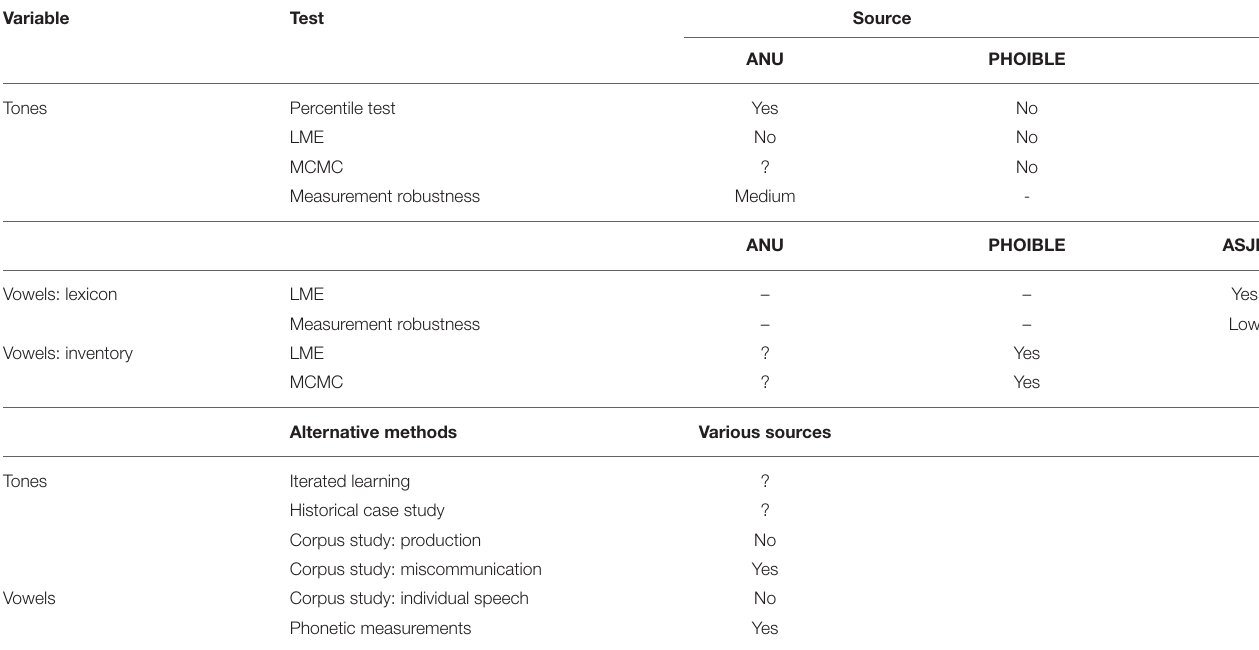
TABLE 5 | A summary of the previous and current results relating humidity to tone and vowels.